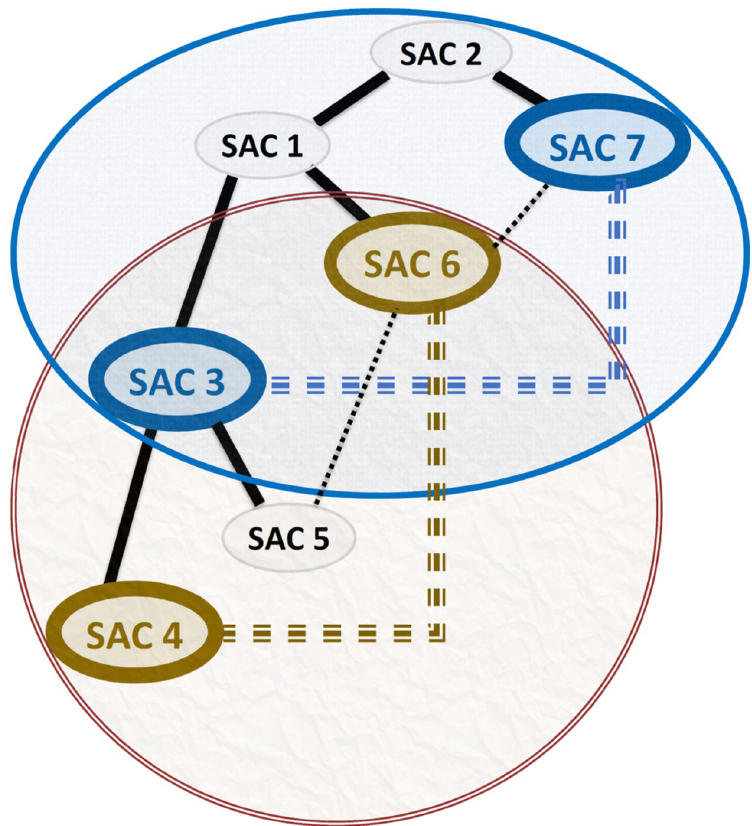
Fig 12. Two subtrees conforming to the RLCA concept. In the first subtree, since SACs 7 and 6 are connected by an edge, SACs 7 and 3 are linked by an implicit Association Edge. In the second subtree, since SACs 6 and 5 are connected by an edge, SACs 6 and 4 are linked by an implicit Association